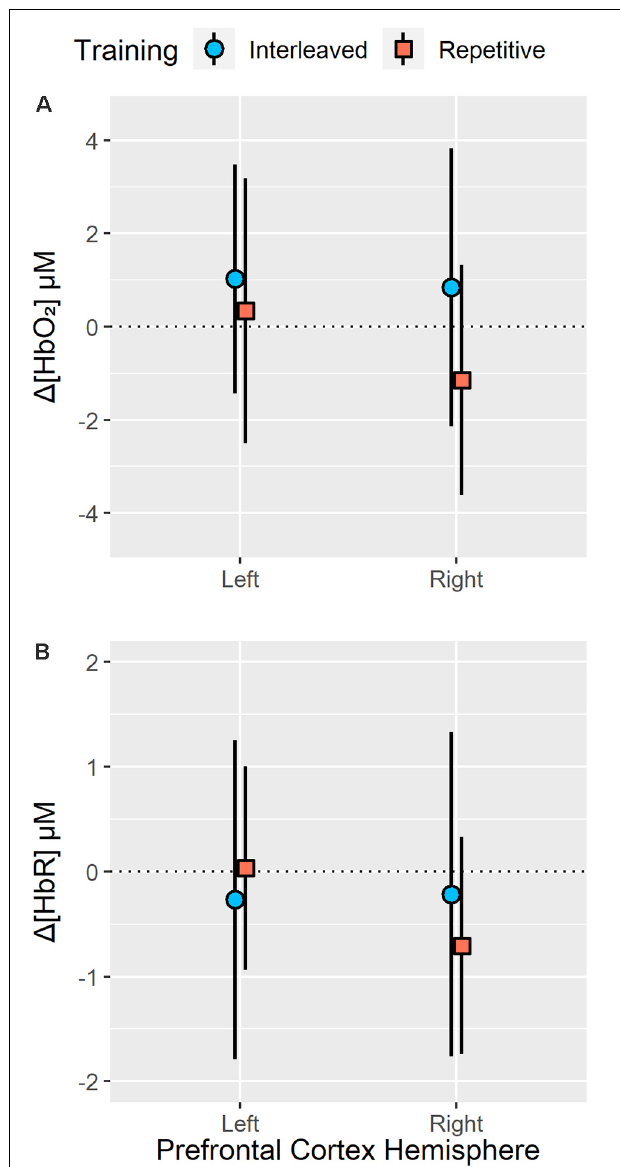
FIGURE 4 | Resting state to task related changes in right and left PFC oxygenated ( ∆ [HbO 2 ]; A ) and deoxygenated ( ∆ [HbR]; B ) hemoglobin concentration during a 24-h delayed test of bimanual five-key press sequences acquired under interleaved or repetitive training schedules. Analysis of right and left PFC ∆ [HbO 2 ] revealed no significant main effect or interactions of training groups (all p > 0.10). In contrast, analysis revealed a significant group × sensor (left or right PFC hemisphere) interaction ( p < 0.05, η 2 p = 0.15) for ∆ [HbR] at test. While interleaved training did not result in any hemispheric differences in ∆ [HbR], repetitive training resulted in significantly lower ∆ [HbR] in the right PFC ( p < 0.05). Error bars represent standard